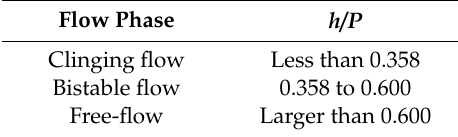
Table 3. Flow phases identified from observed data as a function of h / P